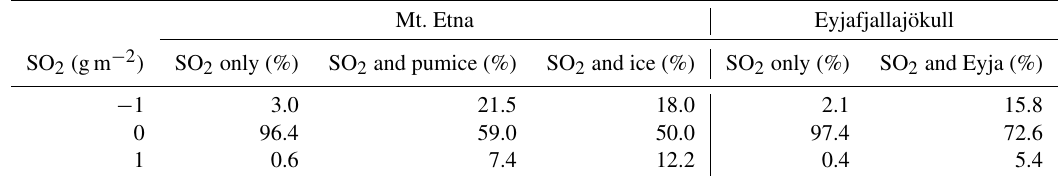
Table 3. Three central bins of the distributions of the differences (VPR retrievals minus true values) for the SO 2 columnar abundance, obtained from the simulations performed for the Sicilian Mt. Etna and the Icelandic Eyjafjallajökull volcanoes. Mt. Etna Eyjafjallajökull SO 2 (gm − 2